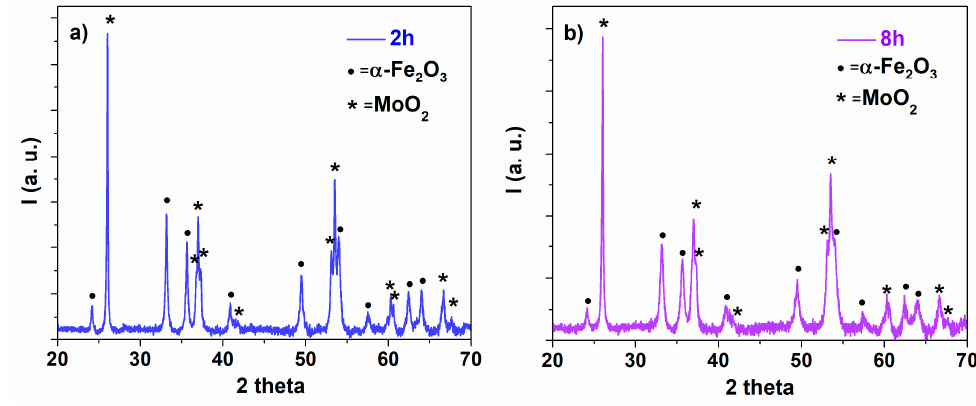
Figure 1. XRD patterns of the equimolar mixture MoO 2 - α -Fe 2 O 3 , corresponding to milling times of ( a ) 2 h and ( b ) 8 h.